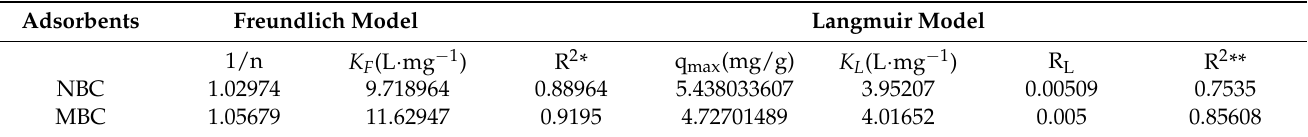
Table 4. Adsorption Isotherms variables.